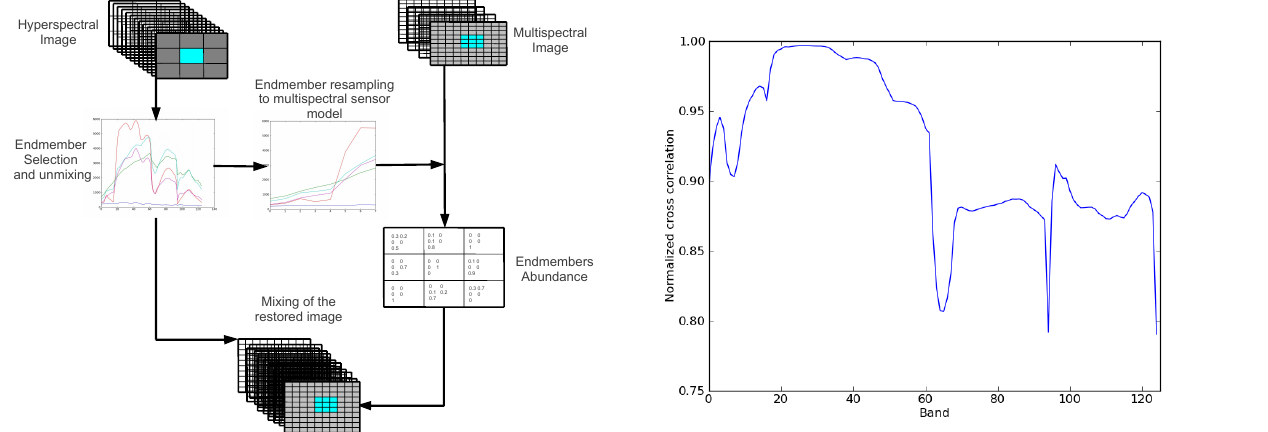
Figure 1: Schema of the proposed algorithm. In a first step, from hyperspectral image endmembers are selected and unmixed, those retrieved endmembers are resampled to the multispectral channels model. The multispectral image is unmixed using the resampled endmembers. Finally a new high resolution hyper- spectral image is retrieved using the result of multispectral un- mixing and hyperspectral unmixing.